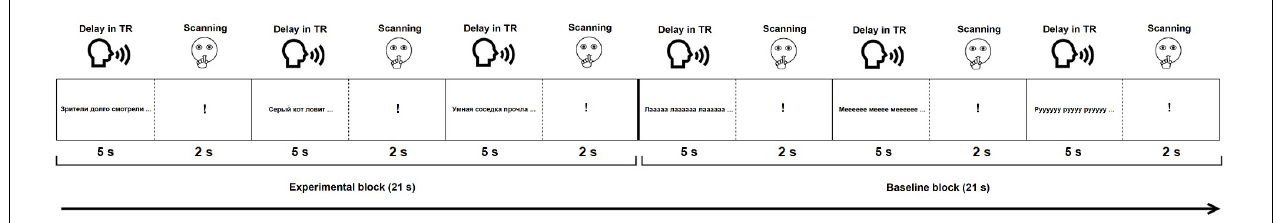
FIGURE 1 | Experimental design of the functional paradigms. For illustration purposes, only stimuli from the SYLL paradigm are presented in the baseline